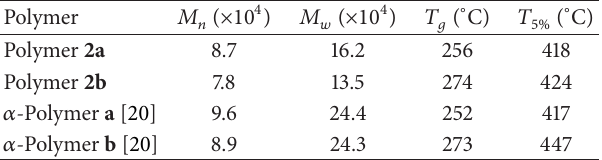
Table 1: Molecular weights and thermal properties of